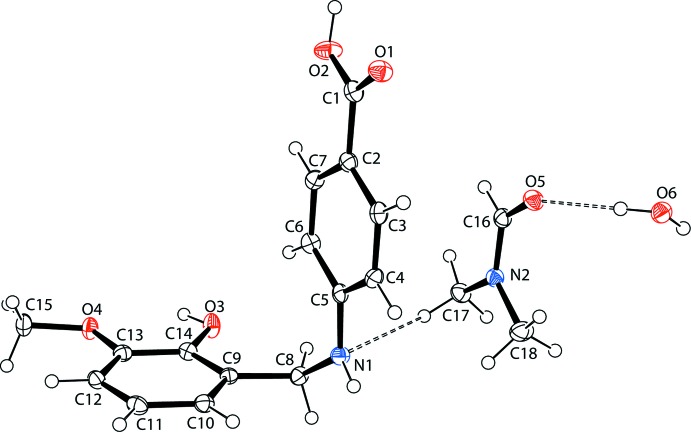
The structures of the mol­ecular entities in the asymmetric unit of the title compound. Displacement ellipsoids are drawn at the 40% probability level. Inter­molecular O—Hwater⋯Oamide and C—Hmeth­yl⋯Namine hydrogen bonds involving the water and di­methyl­formamide solvent mol­ecules are shown as dashed lines (see Table 1 ▸ for numerical details).